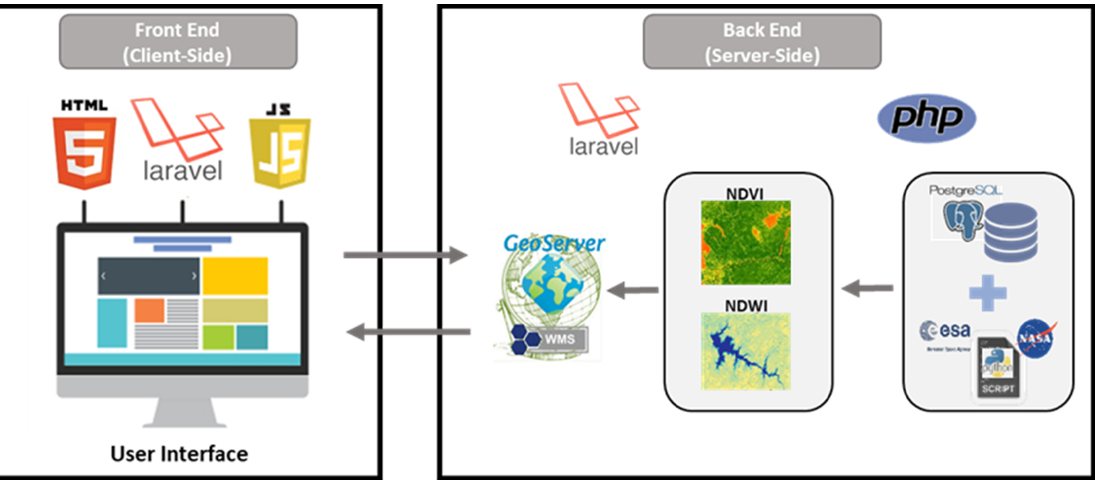
Figure 1. Workflow behind INSPECTORMAP, the Spatial Data Infrastructure proposed for the maintenance of photovoltaic plants.